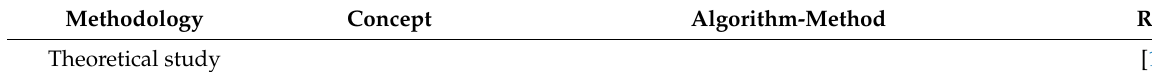
Table 2. Literature review of the methods used for NTL